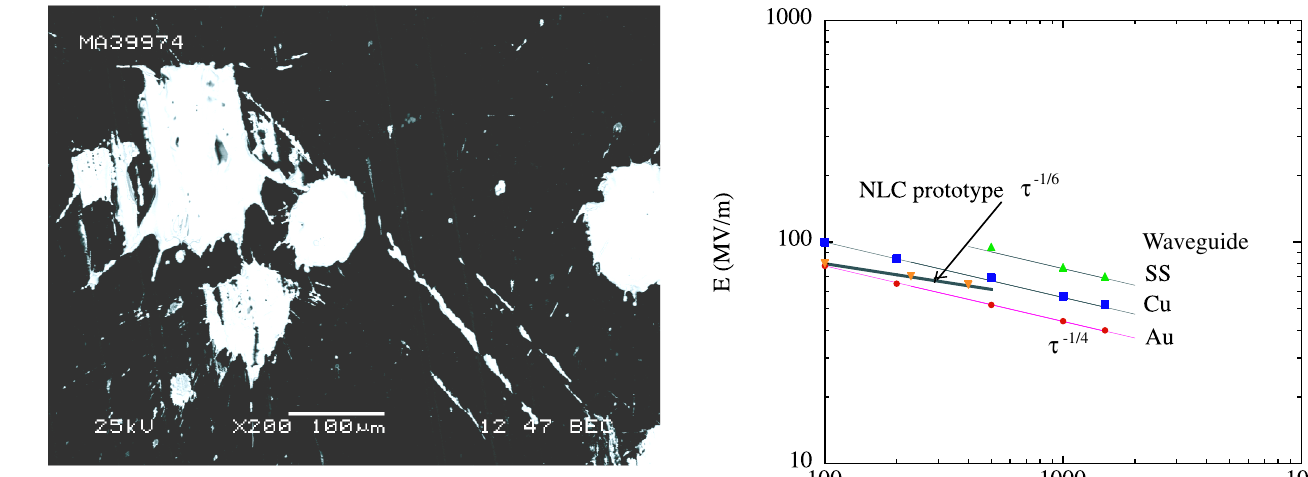
10. (Color) Scanning electron microscope photo of copper splashed on a Be window during breakdown events. This data is described in Ref. [8].